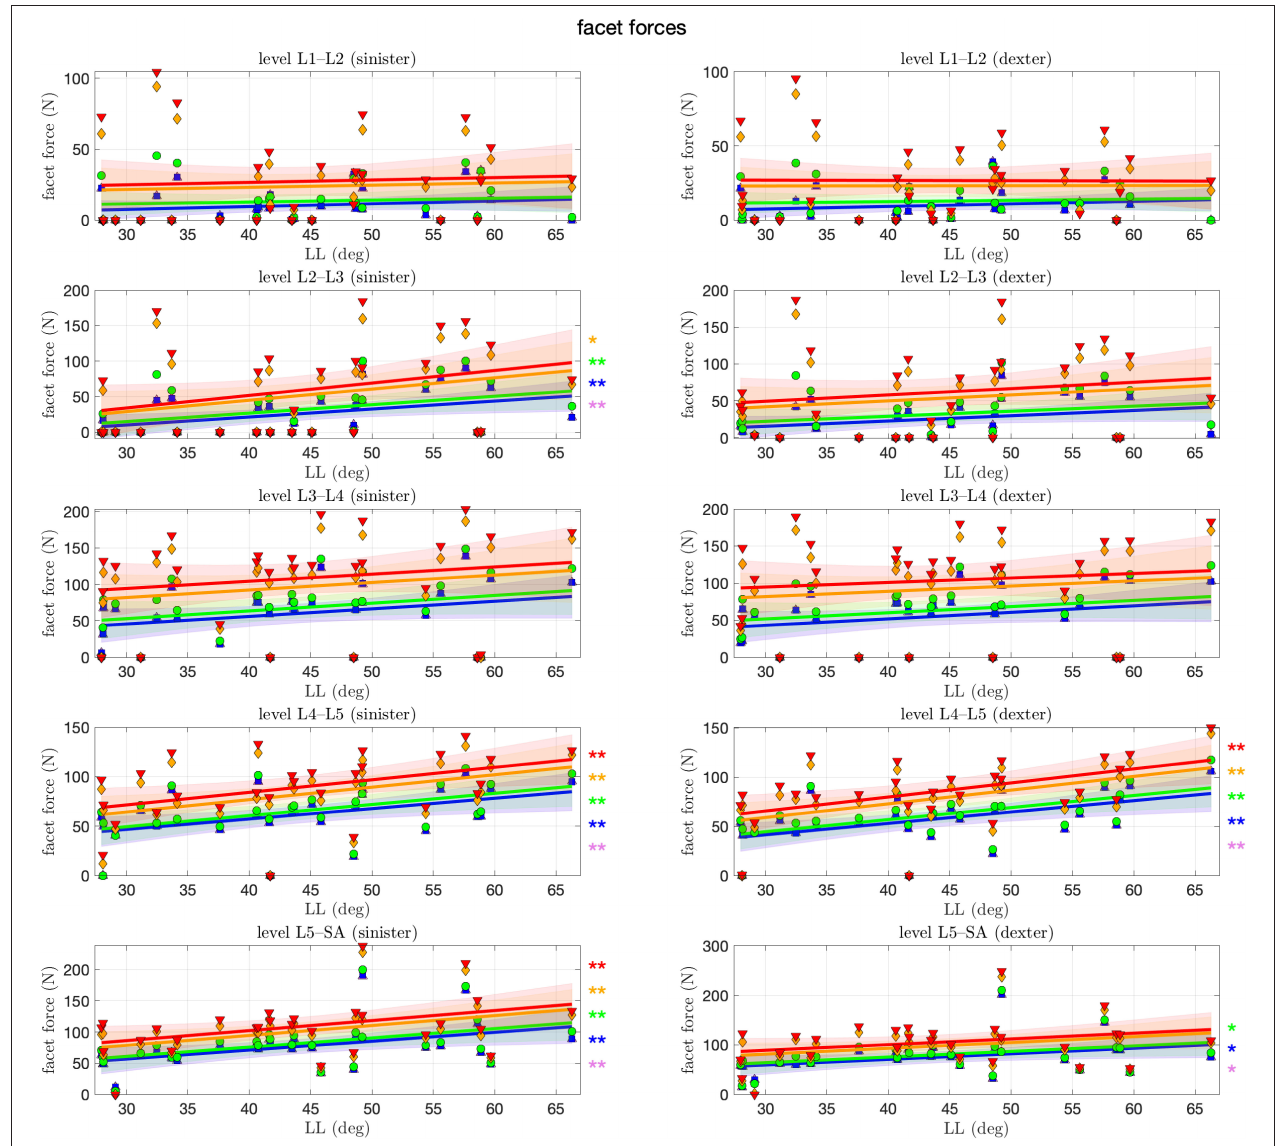
FIGURE 8 | Facet force between each pair of adjacent articular facets against lumbar lordosis (LL). Colors and marker symbols of the data points and the corresponding regression lines consistently correspond to the modes: lilac up-pointing triangles for simulations without muscles involved; blue squares for passive muscles; as well as green circles, orange diamonds, and red down-pointing triangles for muscle stimulation of u statistical test is indicated by alongside asterisks (*